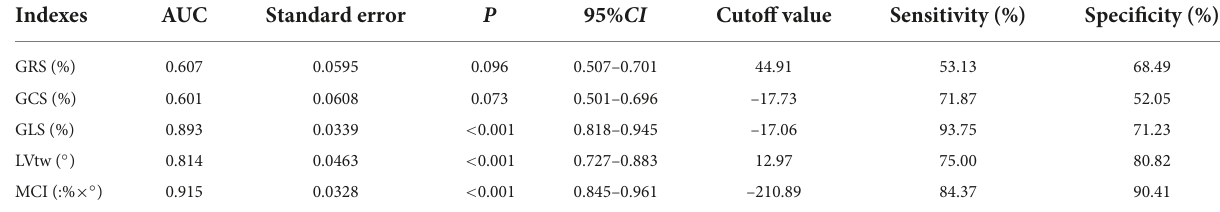
TABLE 4 Results of ROC analysis of 2D-STE parameters and MCI.